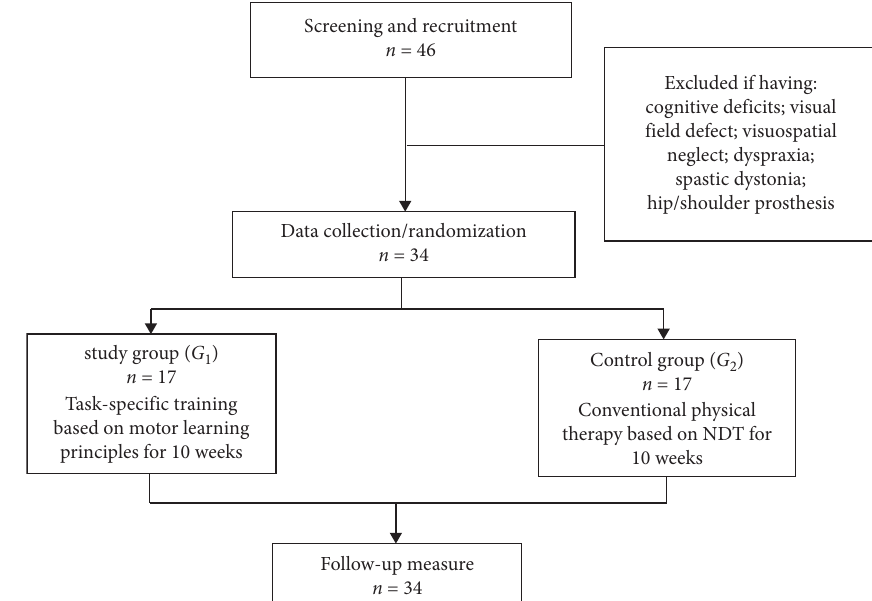
Figure 1: Study flowchart: n number; NDT: neurodevelopmental technique.